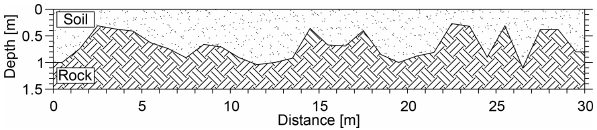
Figure 5. Simulated spatial distribution of the soil depth for the selected